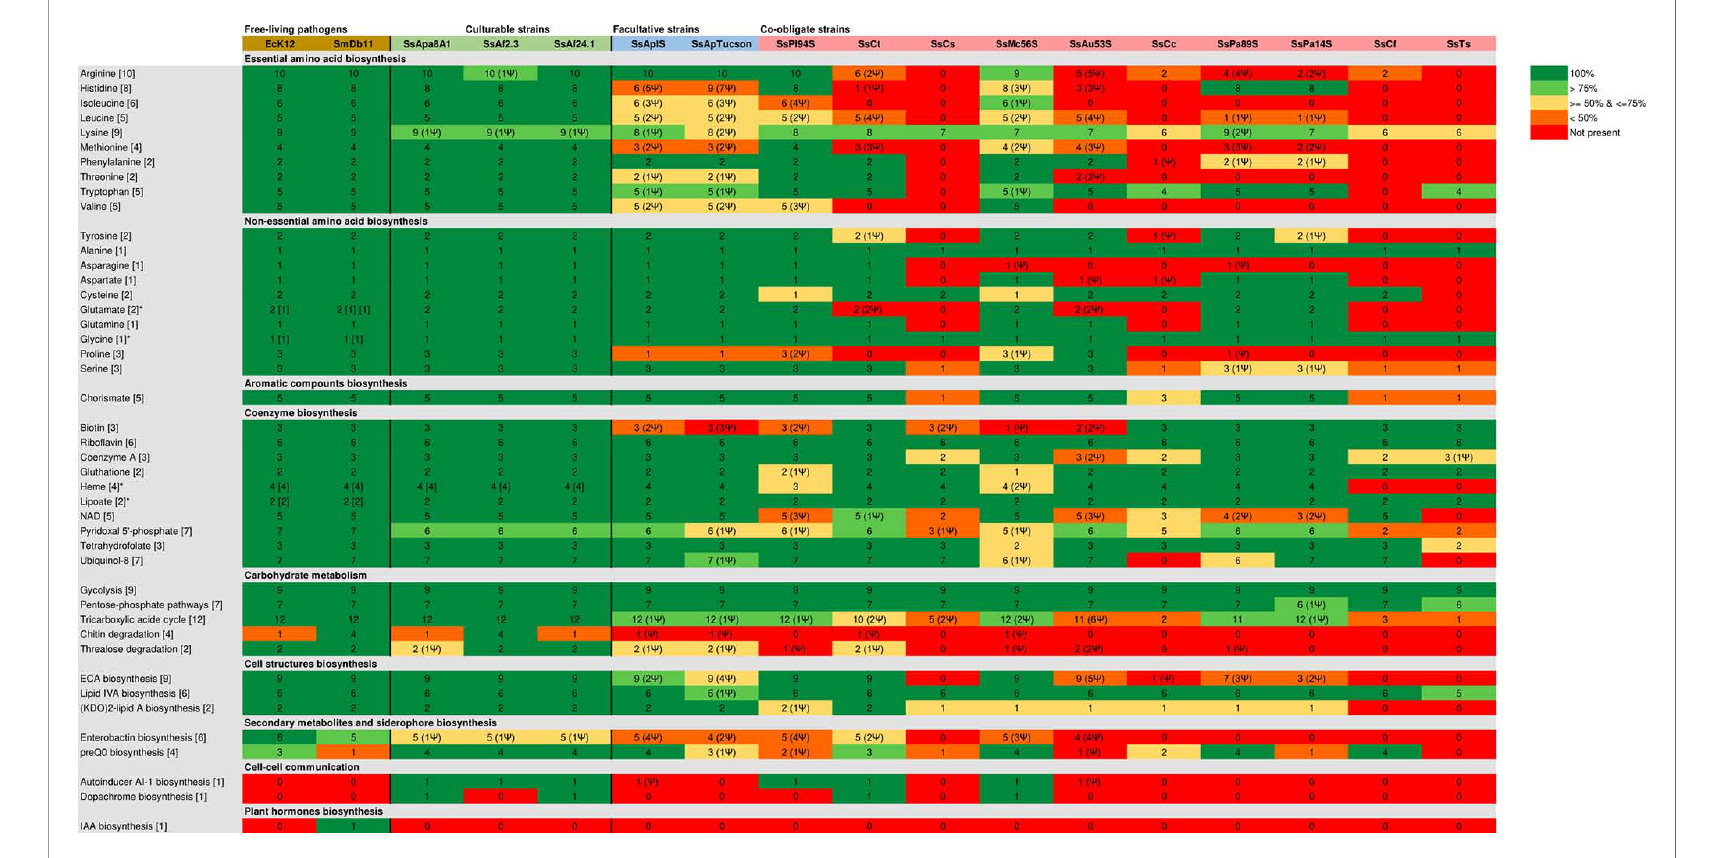
FIGURE 5 | Comparison of metabolic genes repertories among the different S. symbiotica strains. The minimal number of genes for a metabolic pathway is shown in each of the brackets. Color represents the completeness of the MetaCyc pathways: dark green for 100%, light green for 99-75%, yellow for 74-50%, orange for 50-1% and red for 0%. Asterisk (*) denotes that the bacterium possesses a complete alternative pathway for the biosynthesis of the fi nal product with the minimal number of genes for the alternative pathway indicated in the brackets. The numbers followed by Y in the round brackets indicate the number of pseudogenes found for the